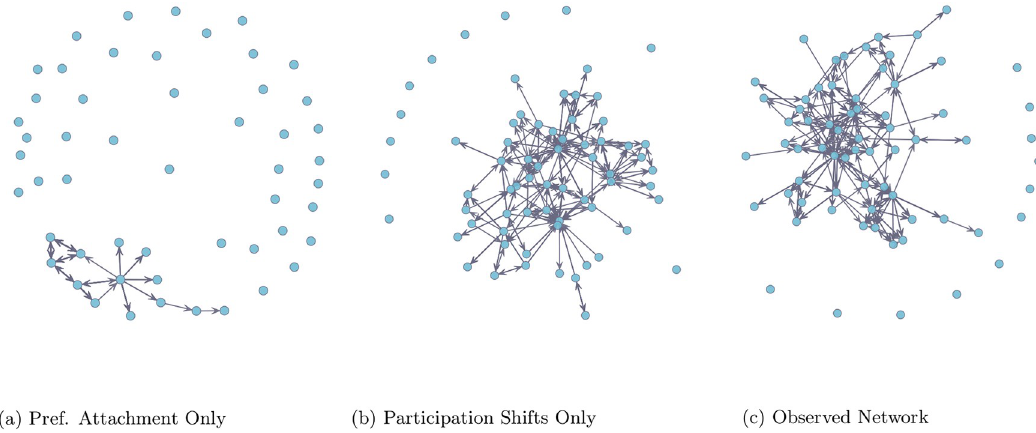
Fig 2. Predicted network comparisons. Preferential attachment and participation shifts as explanations of network structure in observed data. Figs (a)-(b) are simulated email networks using fitted parameters from a model including only preferential attachment and participation shifts, respectively. The network structure in simulated network (b) tends to resemble the observed network (c), though (a) is the typical explanation of long-tailed degree structure. 300 email events were simulated among 94 nodes.